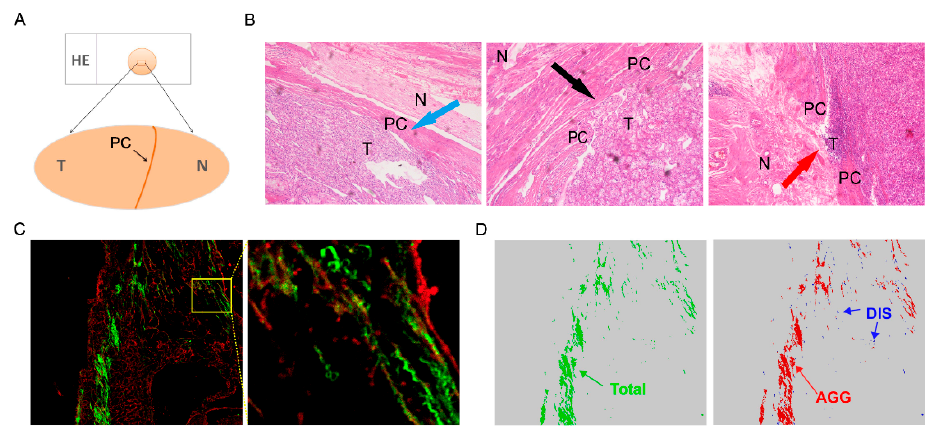
Figure 1. Acquisition of paraffin sections and illustration of PC status and parameters. ( A ) Paraffin sections containing tumor, PC and adjacent normal parenchyma tissues were identified according to HE staining (Hematoxylin eosin staining). ( B ) PC status: PC-, completely intact PC (blue arrow); PC+, PC invasion with (black arrow) or without tumor penetration (red arrow). ( C ) Illustration of collagen proportional area (CPA) (green) / two-photon excitation fluorescence (TPEF) (red) images. ( D ) Illustration of total (green), aggregated (red) and distributed (blue) collagen fibers (T: Tumor; N: Normal tissue; PC: pseudo-capsule; Dis (DisCPA): percentage of distributed collagen proportional area; Agg (AggCPA): percentage of aggregated collagen proportional area). Table 1. Characteristics of patients with clear cell renal cell carcinoma (ccRCC). Features